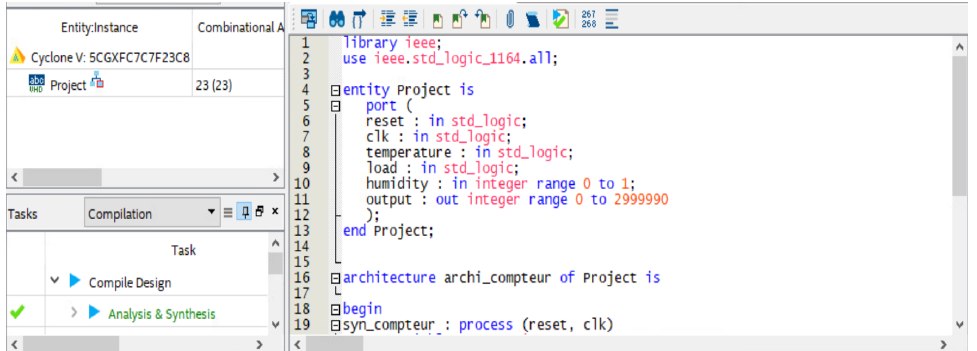
Figure 6. VHDL pseudo-code describing the logic gates of the smart sensor.